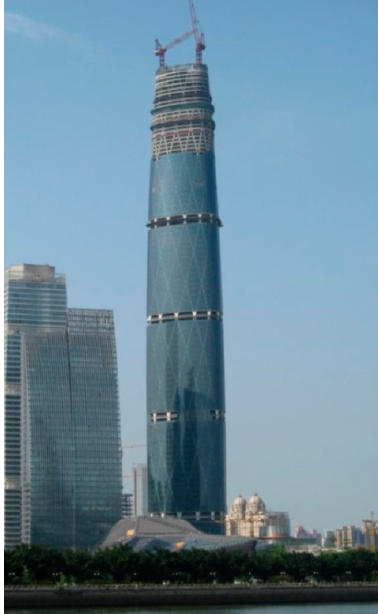
Figure 8. Guangzhou International Finance Center (Source: Wikipedia).